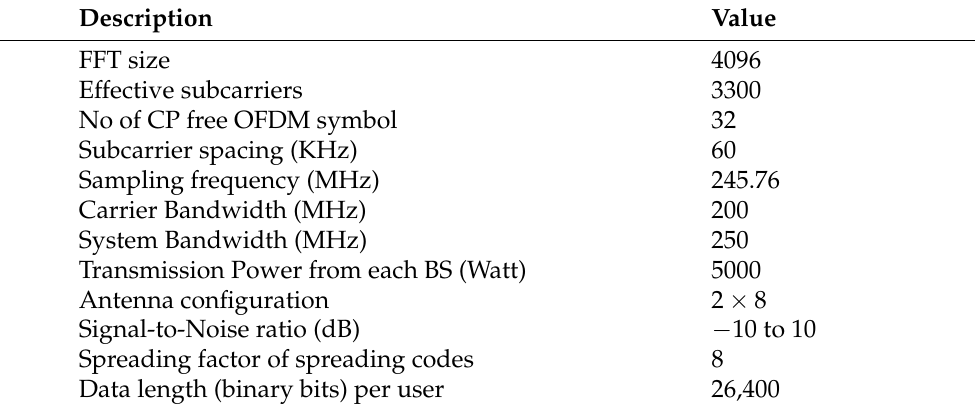
Table 2. Simulation Parameters.